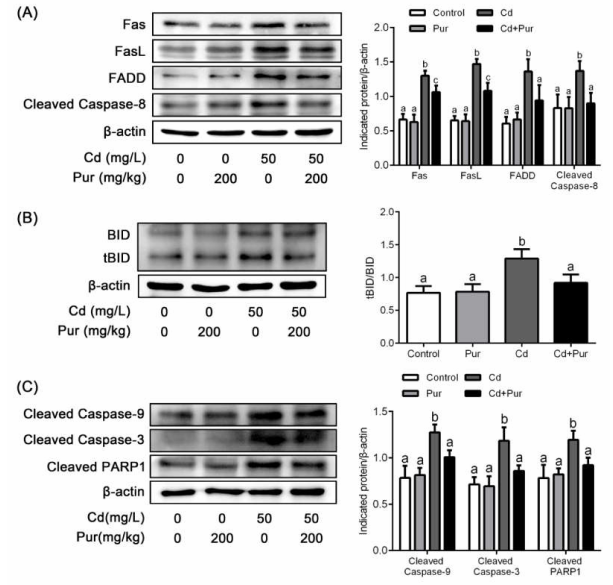
Figure 4. Pur attenuates Cd-induced apoptosis via inhibiting the Fas/FasL-mediated mitochondrial apoptotic pathway in the rat cerebral cortex in vivo. Rats were treated with Cd (50 mg/L) and/or Pur (200 mg/kg) for 90 days. ( A ) The levels of Fas, FasL, FADD, and Cleaved Caspase-8; ( B ) ratio of tBID/BID; and ( C ) the levels of Cleaved Caspase-9, Cleaved Caspase-3, and Cleaved PARP1 were detected by Western blot. Left panel: representative Western blot image; right panel, quantitative analysis (mean ± SD, n = 3). The means labeled without a common letter (a, b, c) are significantly different, p < 0.05.